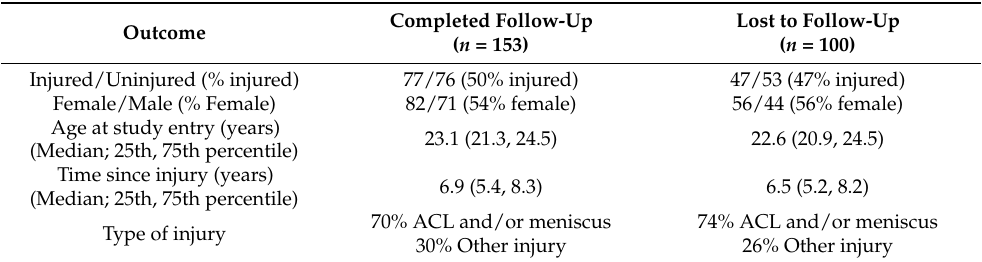
Table A1. Baseline characteristics of those who completed at least two measurements vs. participants who were lost to follow-up and eligible for study